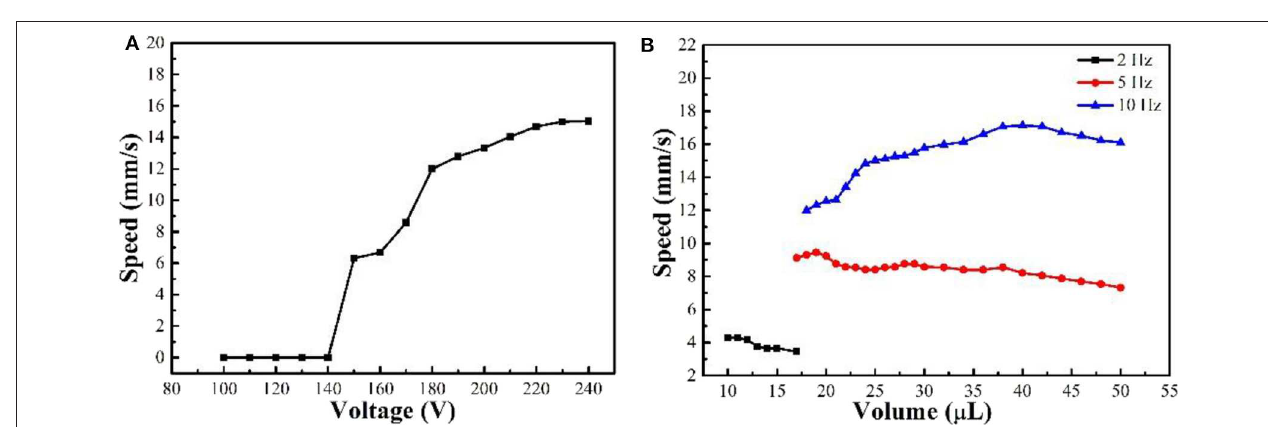
FIGURE 13 | Device performance testing. (A) when the droplet volume is 25 µ L, and the dielectric hydrophobic layer is Parafilm M & silicone oil, the relationship between the driving voltage and the droplet moving speed. (B) When the driving voltage is 240V, the relationship between the droplet volume and the droplet moving